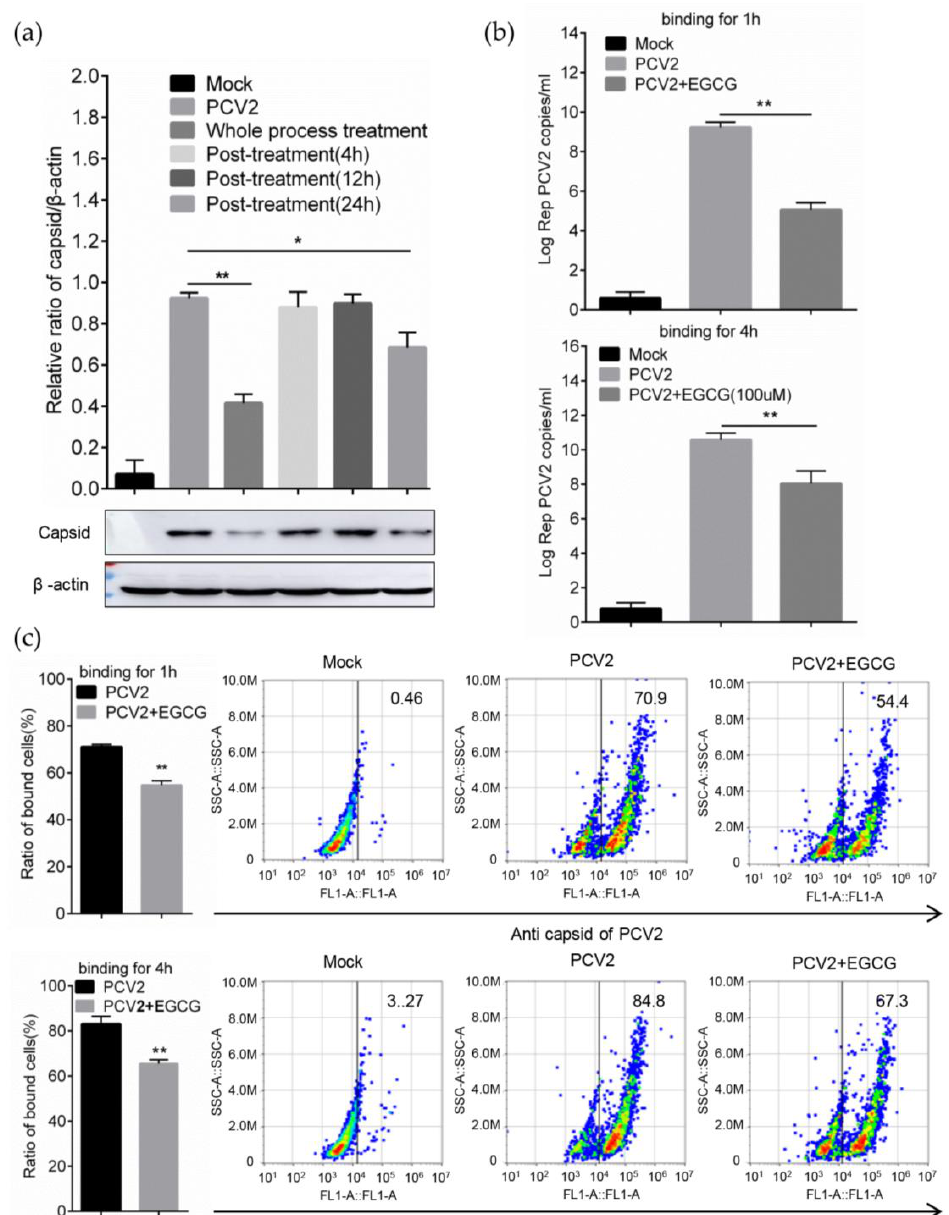
Figure 3. EGCG prevents PCV2 virions binding to host cells. ( a ) Cells were inoculated with PCV2 at MOI = 1.0 with 100 μM EGCG treatment during all the phases, or followed by post-treatment of EGCG for 4 h, 12 h and 24 h, respectively, after which the cells were maintained without EGCG until determined with immunoblotting at 72 hpi. ( b – c ) Virus was added to PK-15 cells at MOI = 5.0 in the presence of 100 μM EGCG. After the binding for 1 h or 4 h at 4 °C. the genome copy numbers of the attached virions were determined using the qPCR method ( b ); PCV2-attached cells were measured by flow cytometry ( c ). Mean ± SD of three independent experiments were shown and Student’s t -test was conducted for statistical analysis (* p < 0.05; ** p < 0.01).